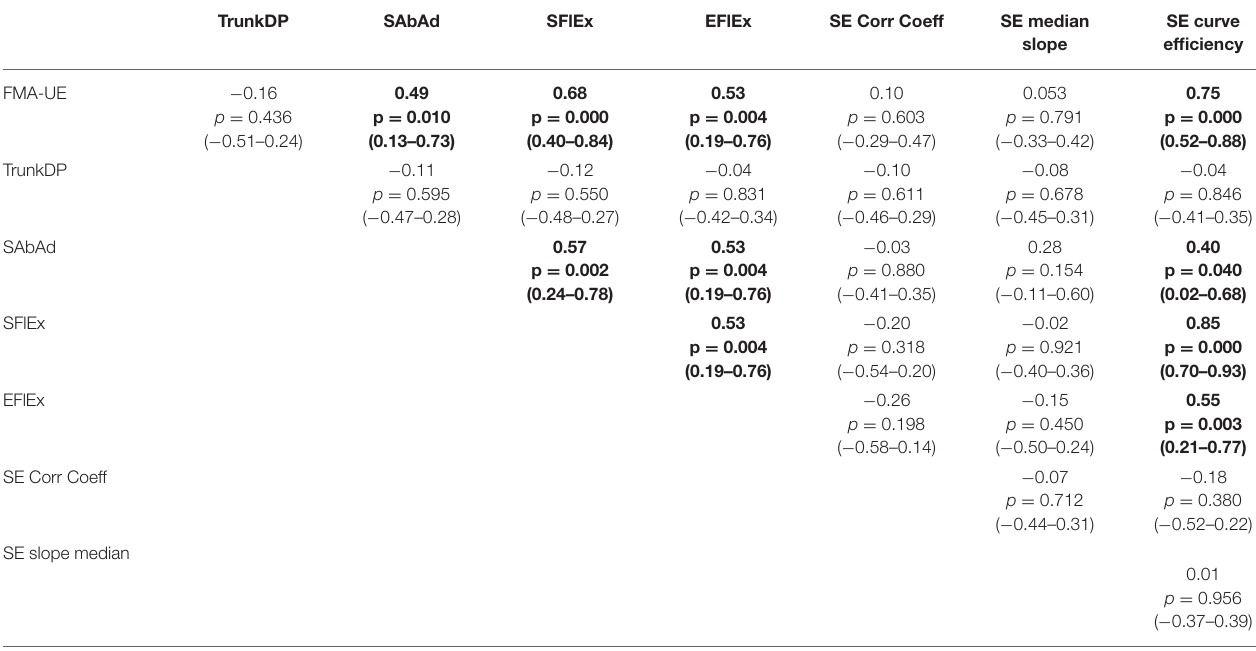
TABLE 5 | Confusion matrix of the correlation coefficients for each measure